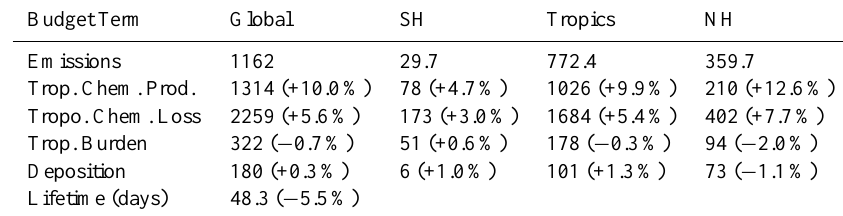
Table 4. As Table 2 but for CH 2 O and budget terms for the MBA given in TgCH 2 Oyr − 1 . Budget Term Global SH Tropics NH Emissions Tropo. Chem. Prod. 1454